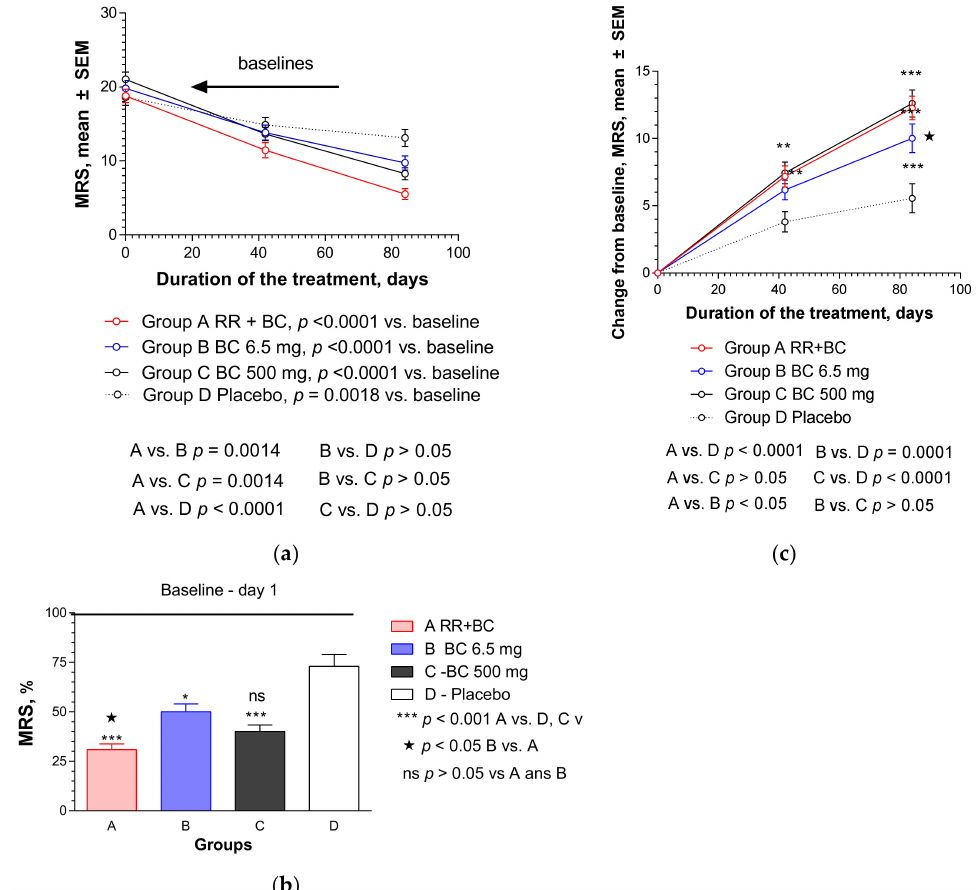
Figure 3. E ff ects of RR-BC (Group A), BC (Group B), BC500 (Group C), and placebo (Group D) on menopausal symptoms after 12 weeks (84 days) of treatment, as assessed using MRS: ( a ) significant decrease of MRS (mean ± SEM) score compared to baseline values was observed in all the groups over time ( p < 0.0001 in groups A, B, C; p = 0.0018—in placebo group); ( b ) significant di ff erence in MRS (% to baseline, 100%, mean ± SEM) was observed in A, B, and C groups compared to placebo group at the end of the treatment—day 84, ( p < 0.001, A vs. D and B vs. D), as well as between groups A and B, but not groups A vs. C and B vs. C; ( c ) statistically significant interaction e ff ects between treatment groups and response (change from the baseline of MRS, mean ± SEM) over time showed significant di ff erences between groups A, B, and C vs. placebo, as well as groups B vs. C, but not A vs. B (two-way ANOVA). Significance of di ff erence between groups at various time points, calculated by Bonferroni post-test, is expressed by symbols * p < 0.05, ** p < 0.01, *** p < 0.001; ns: not significant (A, B, and C vs. placebo) and * p < 0.05 (B vs.